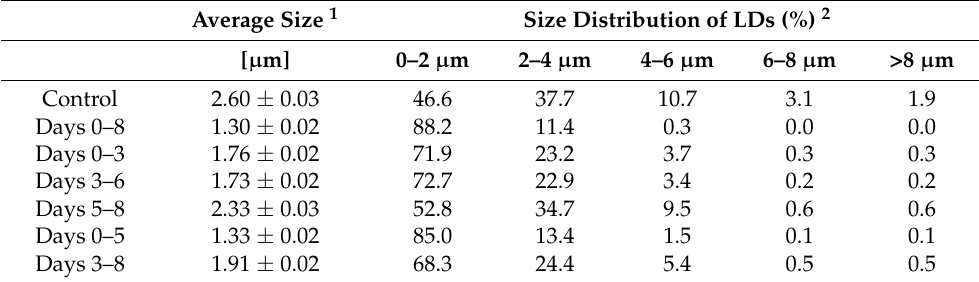
Table 1. Average size of lipid droplets (LDs) in each condition.